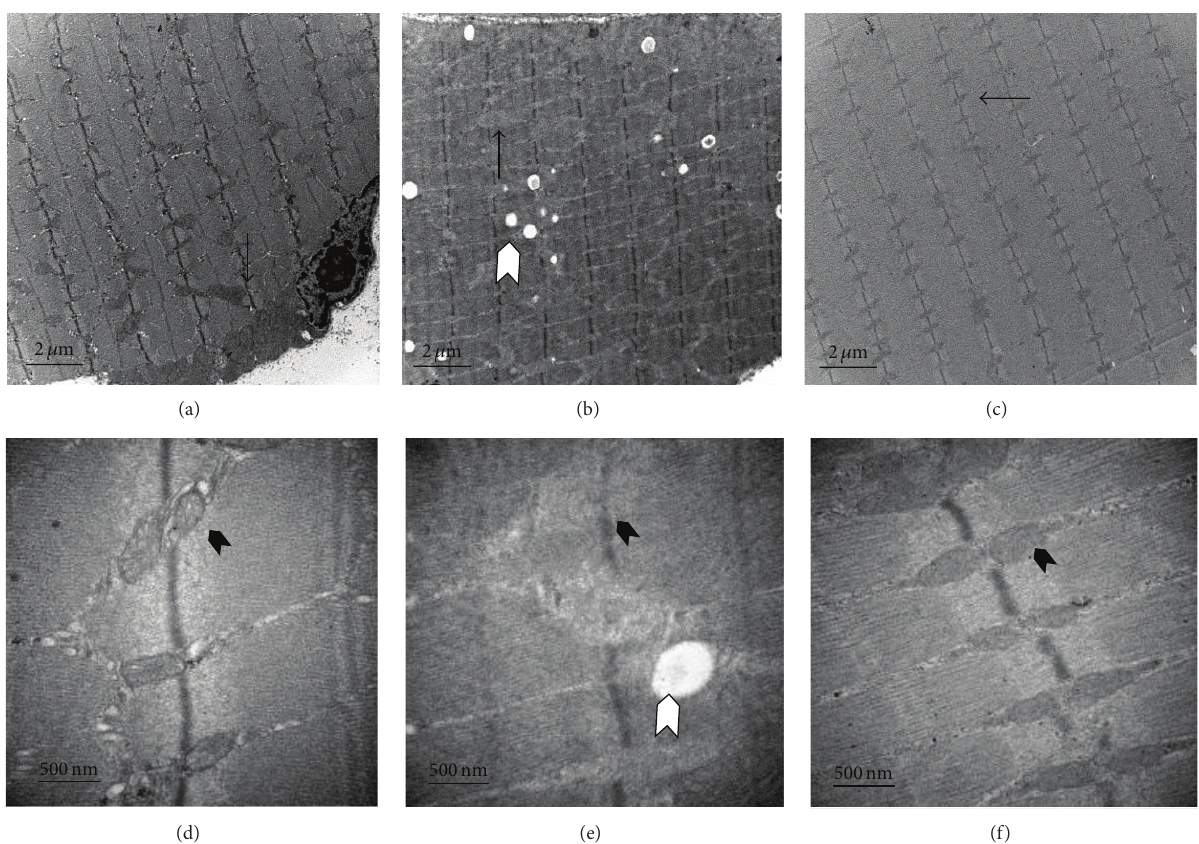
Figure 2: Electron micrographs of skeletal muscle tissue. Normal mitochondria and myofibril in skeletal muscle of normal mice ((a), (d)). Disordered myofibril and mitochondria with fuzzy cristae in skeletal muscle of diabetic model mice ((b), (e)). Improved myofibril and mitochondria with clearer cristae than diabetic mice in skeletal muscle of diabetic mice treated with liraglutide for 6 weeks.